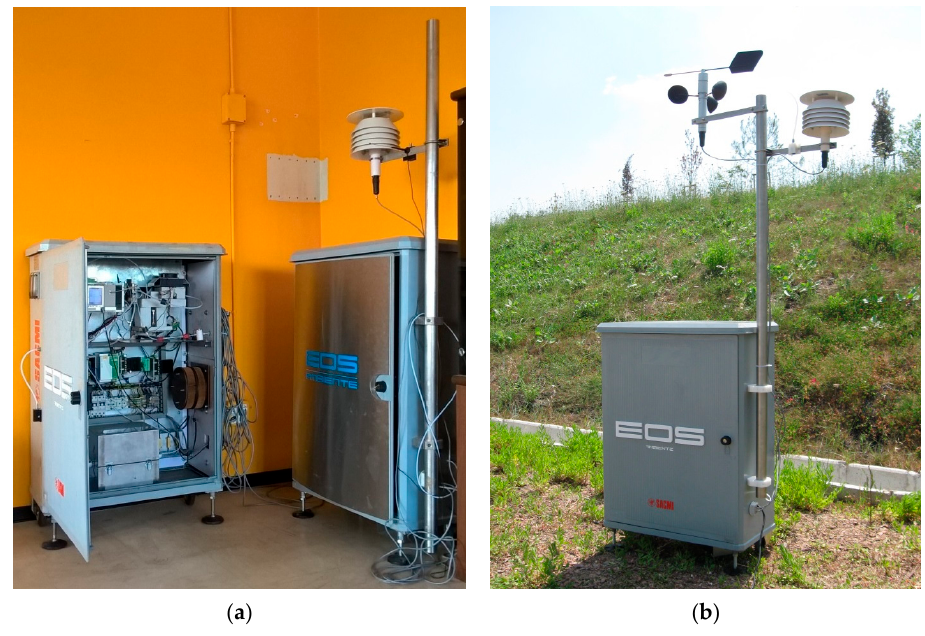
Figure 1. Electronic noses used for the tests in laboratory ( a ) and EOS 507 in the field ( b